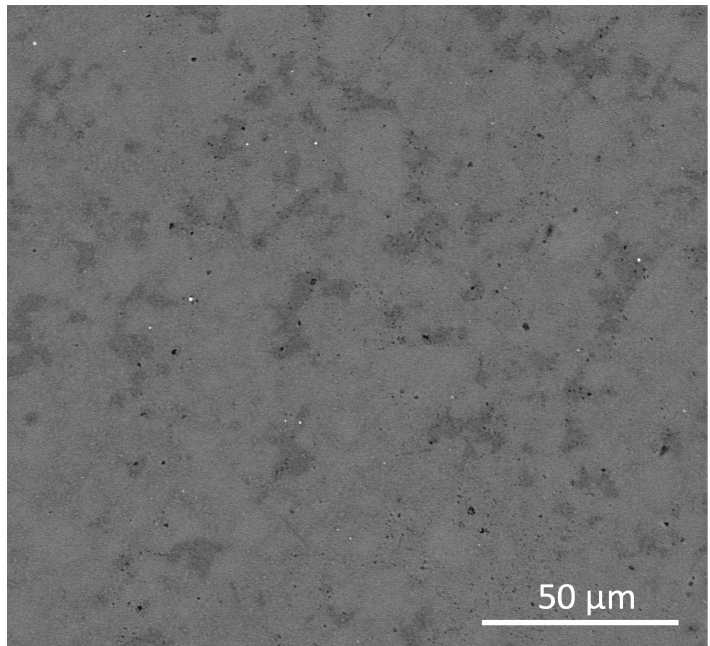
Figure 2. Temperature-dependent displacement curve (black solid line) recorded during the sintering process of specimen 1. Inset highlights the derived corresponding shrinkage rate (blue solid line).